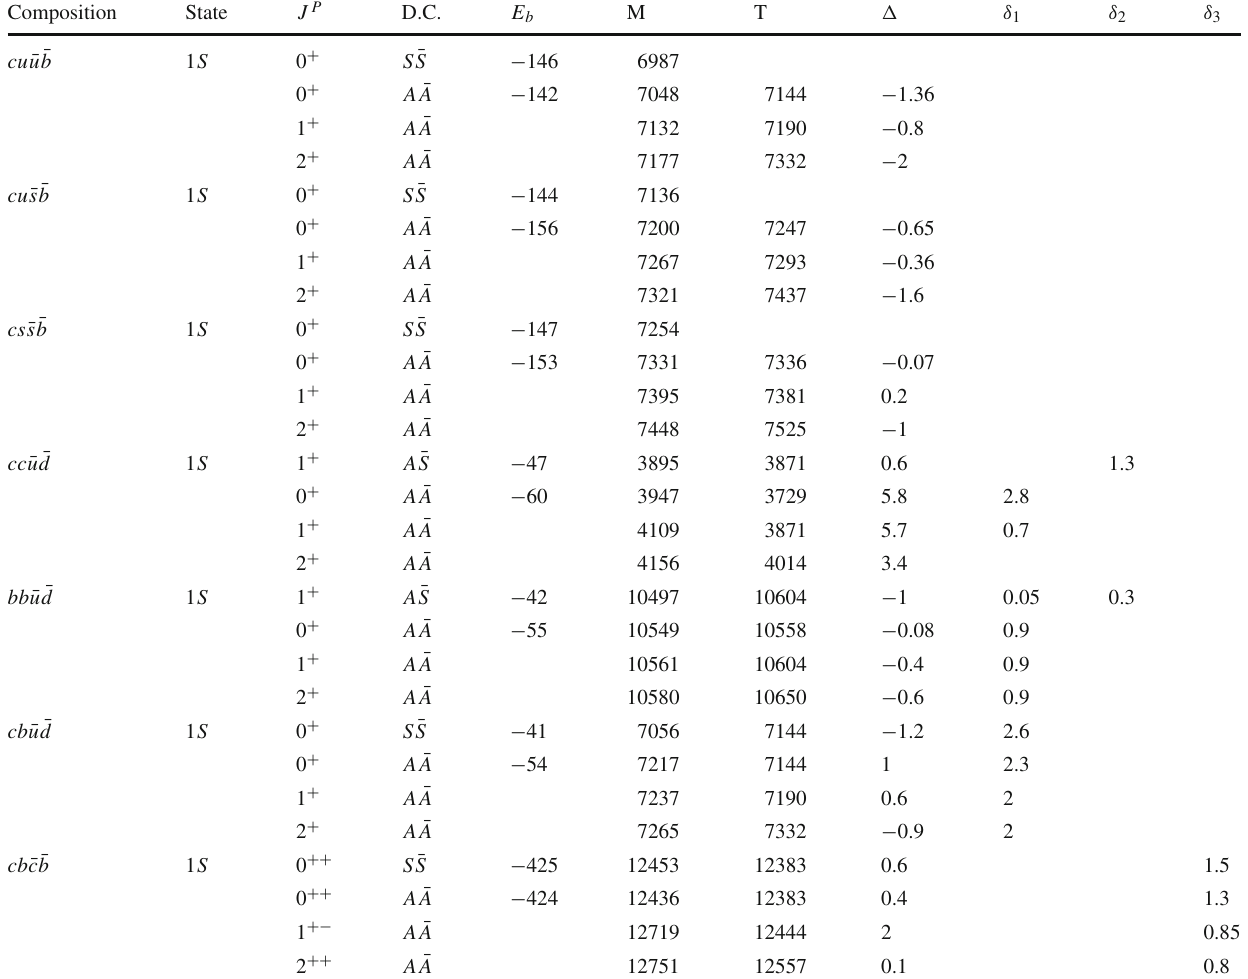
δ 3 is the percentage difference between our results and Refs. [28,40]. T isthelowestthresholdfordecaysintotwomesonsand (cid:9) = ( M − T ) 100 is the percentage difference between our results and T [40](in